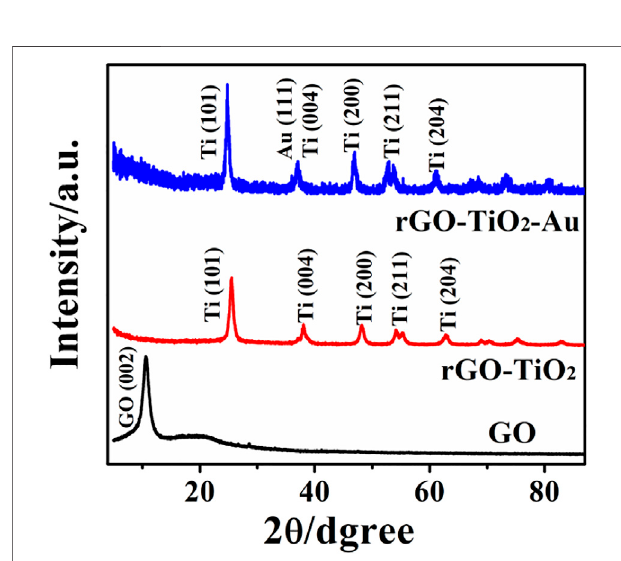
FIGURE 2 | XRD patterns of GO, rGO – TiO 2 , and rGO – TiO 2 – Au nanocomposites.